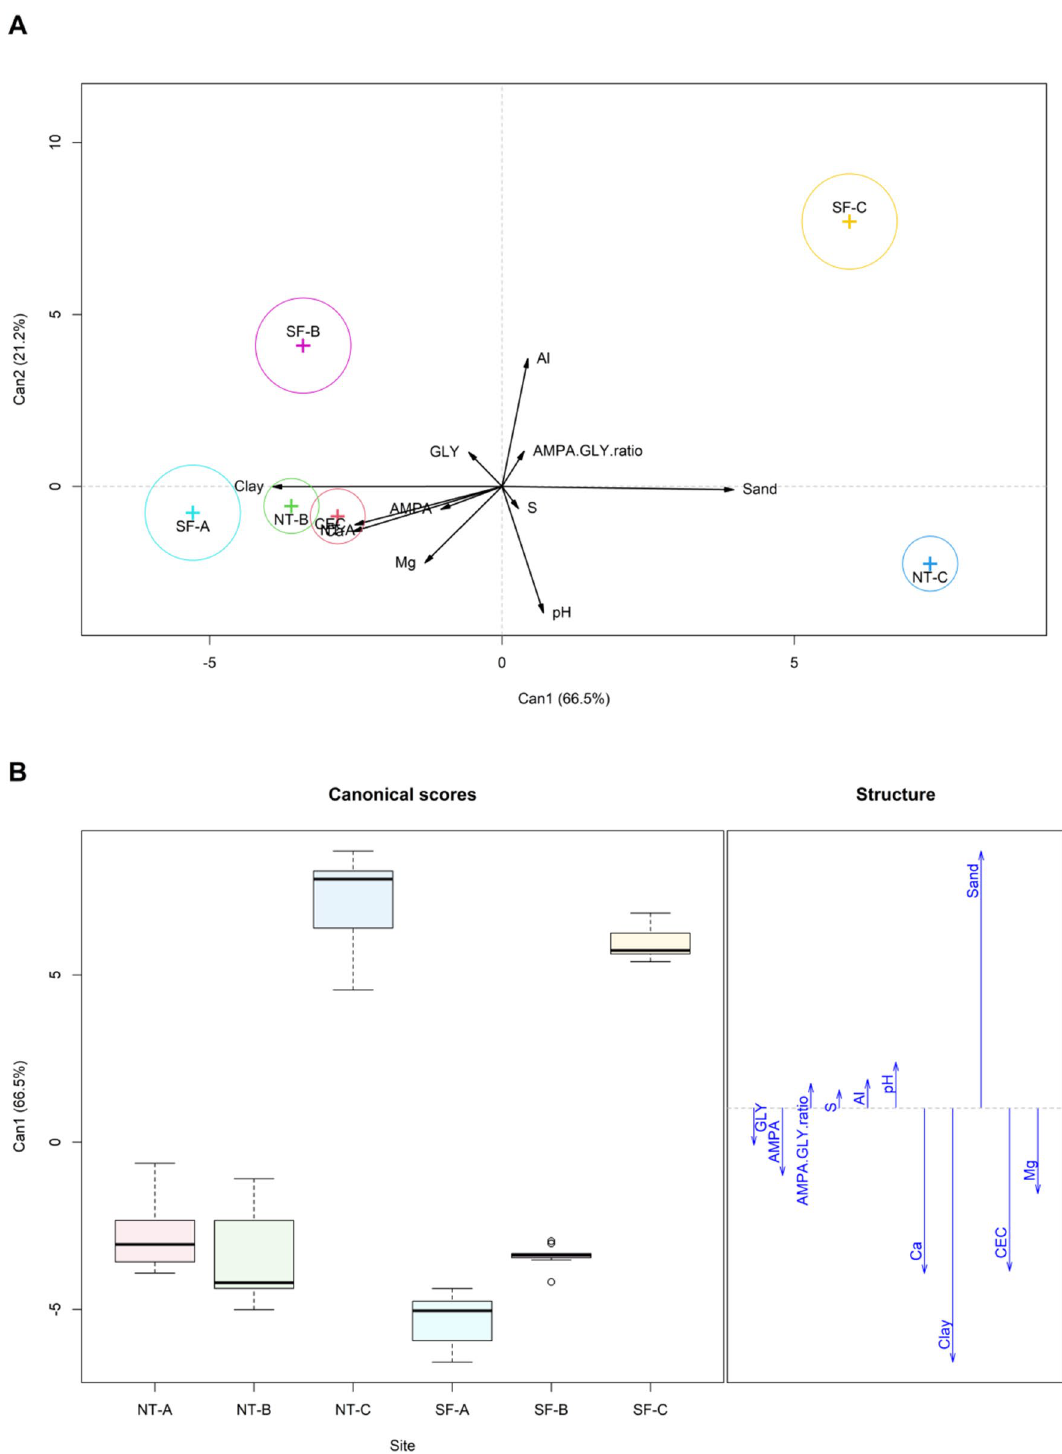
Figure 3. Maximum canonical discriminant function among study sites explaining 87.08% in two canonical axes. ( A ) Generalised canonical discriminant analysis to identify vector behaviour in relation to study sites in a multivariate linear model plotted in canonical space. ( B ) Unfolding of the principal axis (Can1) of canonical discriminant analysis from summarised modelling of canonical discriminant function, seeking linear combinations of quantitative variables to identify the factors that separate groups to the maximum. A, B, C study sites; NT no-tillage; SF secondary